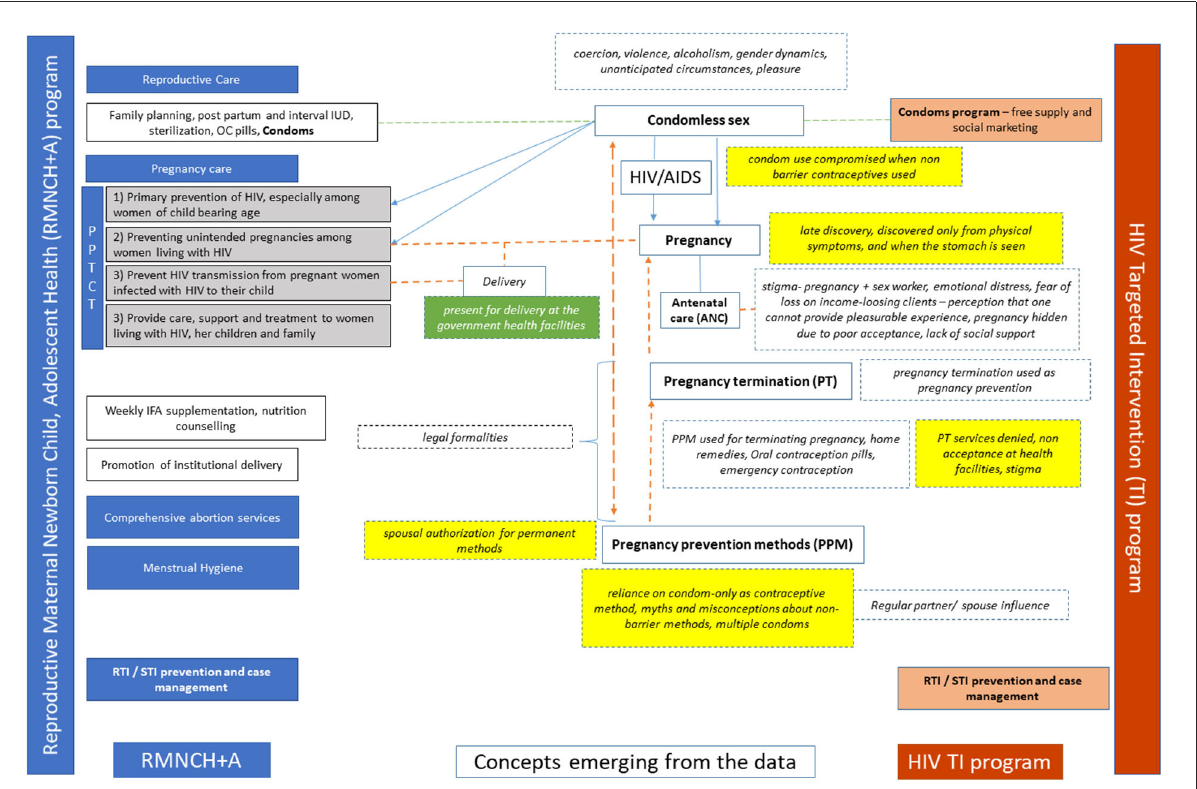
FIGURE1 Analytical framework highlighting gaps and opportunities for FSWs’ engagement in reproductive health services within the existing RMNCH + A and the Targeted Intervention